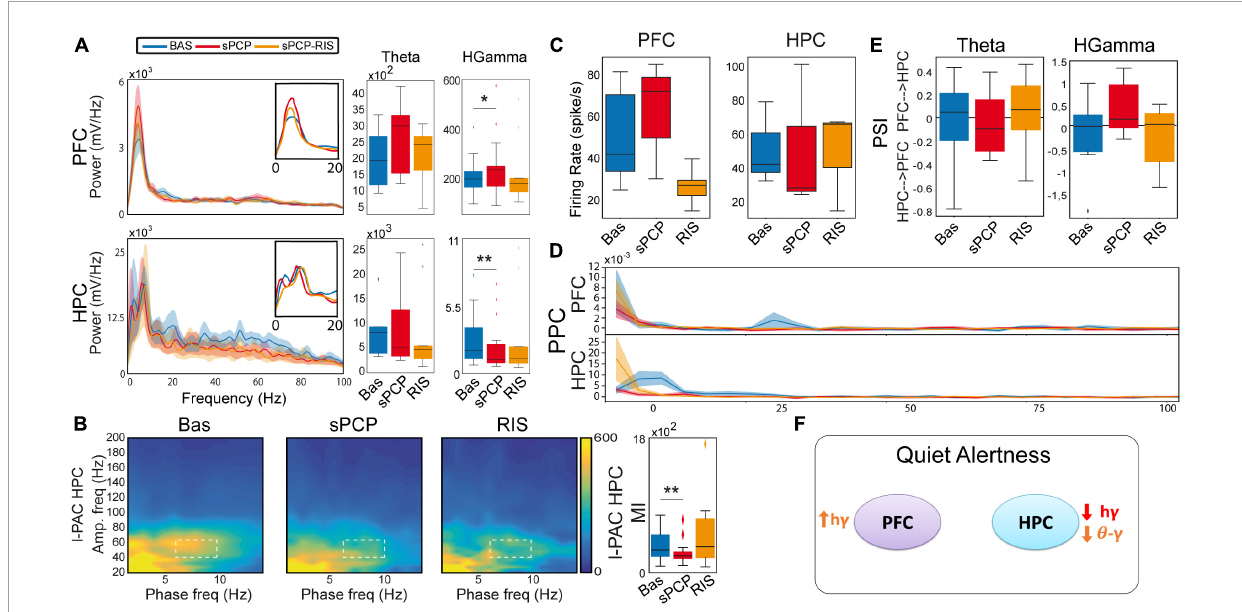
FIGURE2 sPCP disrupted theta and gamma synchronization in mPFC-dHPC circuits during quiet wakefulness. Some of these alterations were ameliorated by risperidone. (A) sPCP increased high gamma power in the mPFC (baseline vs. sPCP: p = 0.047, paired t -test; n = 21 mice) and decreased it in the dHPC ( p = 0.004). Risperidone rescued aberrant gamma power in the mPFC ( F ( 2 , 16 ) = 0.11, p = 0.9; one-way repeated measures ANOVA; no post-hoc differences between BAS and sPCP-RIS), but not in the dHPC ( F ( 2 , 14 ) = 6.73, p = 0.01). (B) sPCP weakened local and inter-regional theta-gamma coupling (6–10 Hz with 40–60 Hz; l-PAC; p = 0.008; ir-PAC PFC phase -HPC amp ; p = 0.001; one-way repeated measures ANOVA) that were partially restored by risperidone ( F ( 2 , 14 ) = 0.23, p = 0.125; no post-hoc differences between BAS and sPCP-RIS). (C) sPCP promoted the spiking activity of neuron populations (multi-unit activity or MUA) in the mPFC that was reduced by risperidone ( F ( 2 , 6 ) = 4.58, p = 0.047). (D) sPCP disrupted the coupling of spikes to theta oscillations in the dHPC that was restored by risperidone ( F ( 2 , 6 ) = 19.4, p = 0.002). Risperidone also boosted spike-delta coupling in the dHPC (3–6 Hz, F ( 2 , 6 ) = 5.39, p = 0.046). Spike-LFP coupling was estimated via the pairwise phase consistency method (PPC). (E) sPCP did not significantly affect the directionality of theta and high gamma signals within the circuit, but some tendencies were observed in the high gamma band. Circuit directionality was estimated via the phase slope index (PSI). (F) Proposed neural mechanism for the effects of sPCP and risperidone on mPFC-dHPC circuits during quiet alertness. In red, changes produced by sPCP, in orange sPCP-induced deviations ameliorated by risperidone. See also Supplementary Figure 3